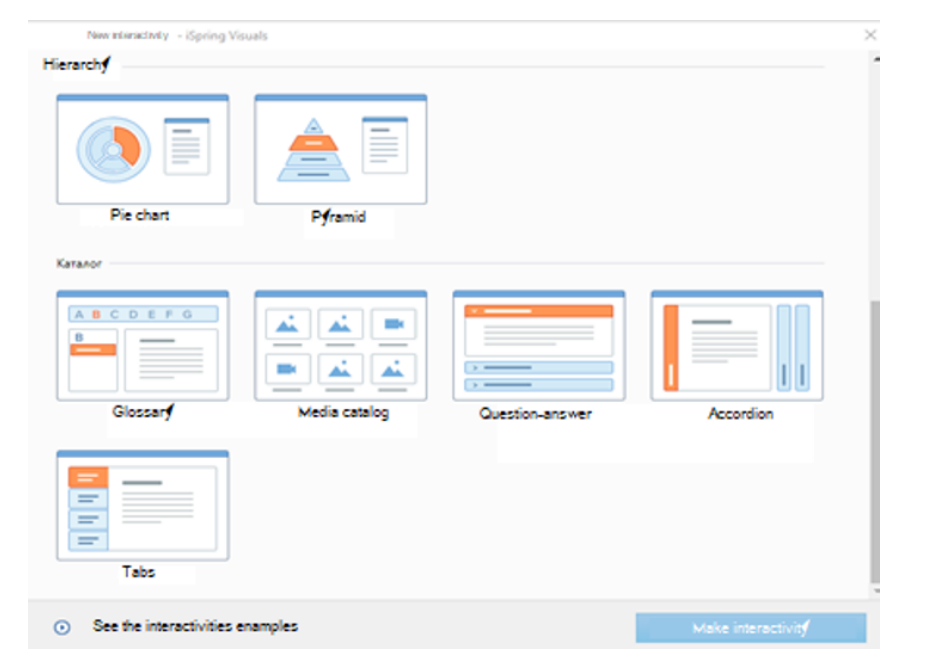
Fig. 5. The model of